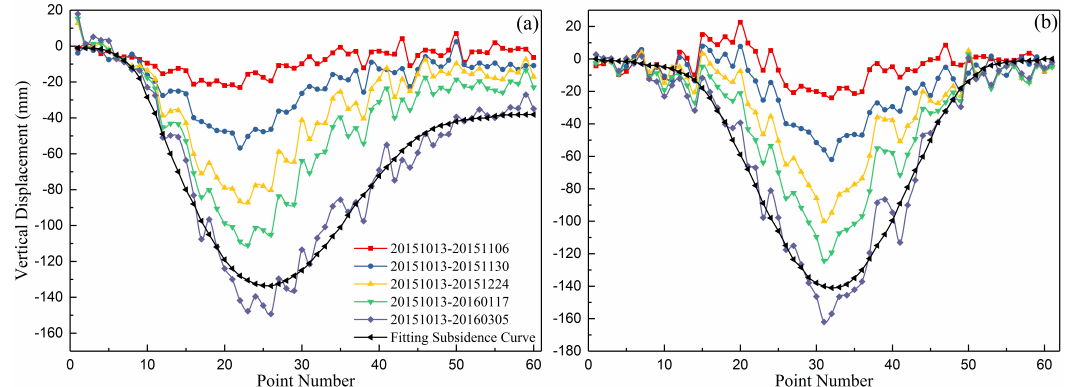
Figure 11. Surface subsidence curves obtained at different periods according to sampling points. ( a ) The subsidence curve in the strike direction; ( b ) the subsidence curve in the dip direction. The sampling points were arranged from northeast to southwest and from small to large in the strike direction, from southeast to northwest and from small to large in the dip